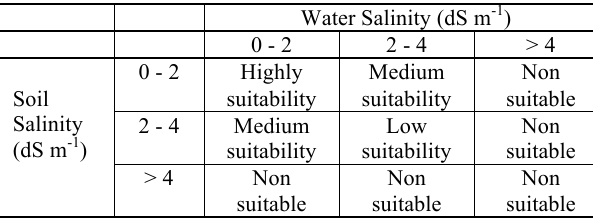
Table 1. Salinity thresholds of soil and surface water used